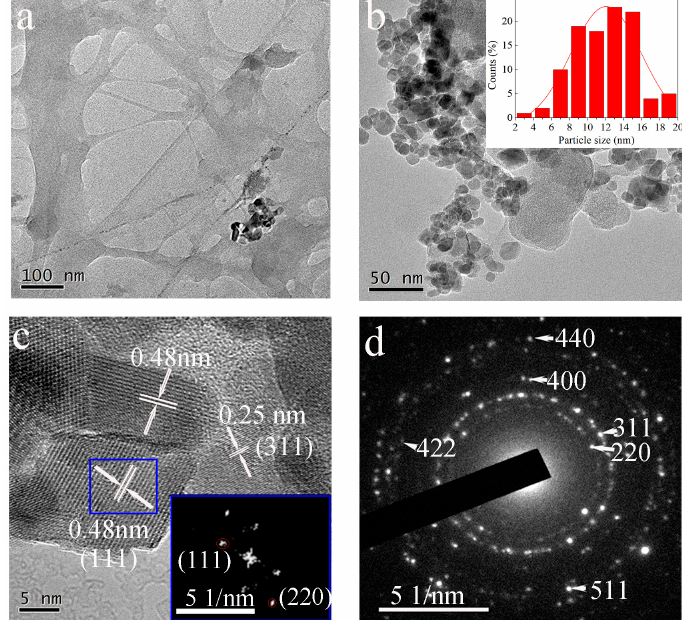
Figure 2. Transmission electron microscopy (TEM) images of treated fiberboard ( a ) and NFF composite board ( b ). The inset in ( b ) shows the particle distribution. The high resolution TEM (HRTEM) image ( c ) and selected area electron diffraction ( d ) of the NFF composite board, and the inset displays the electron diffraction of the blue area in ( c